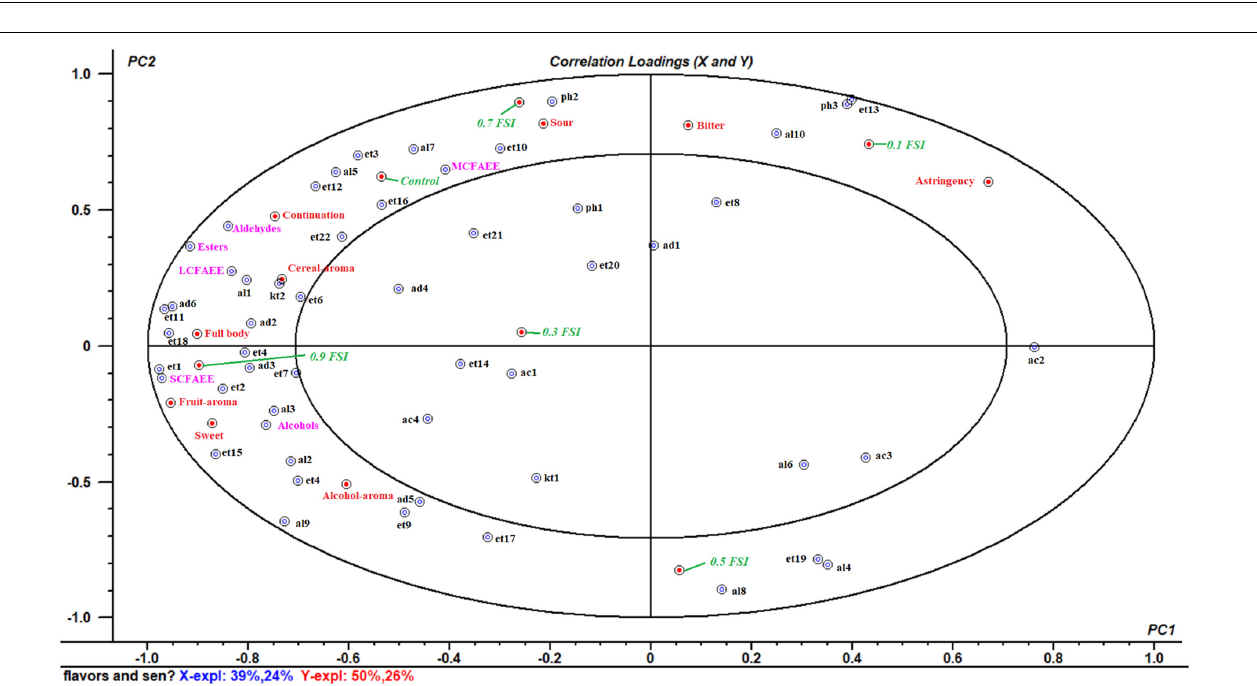
FIGURE 6 | Correlataion loadings plot between the fifty-three volatile flavor compounds and nine sensory attributes in HQW containing different concentrations of FSI (The codes were defined in Table 1 ).